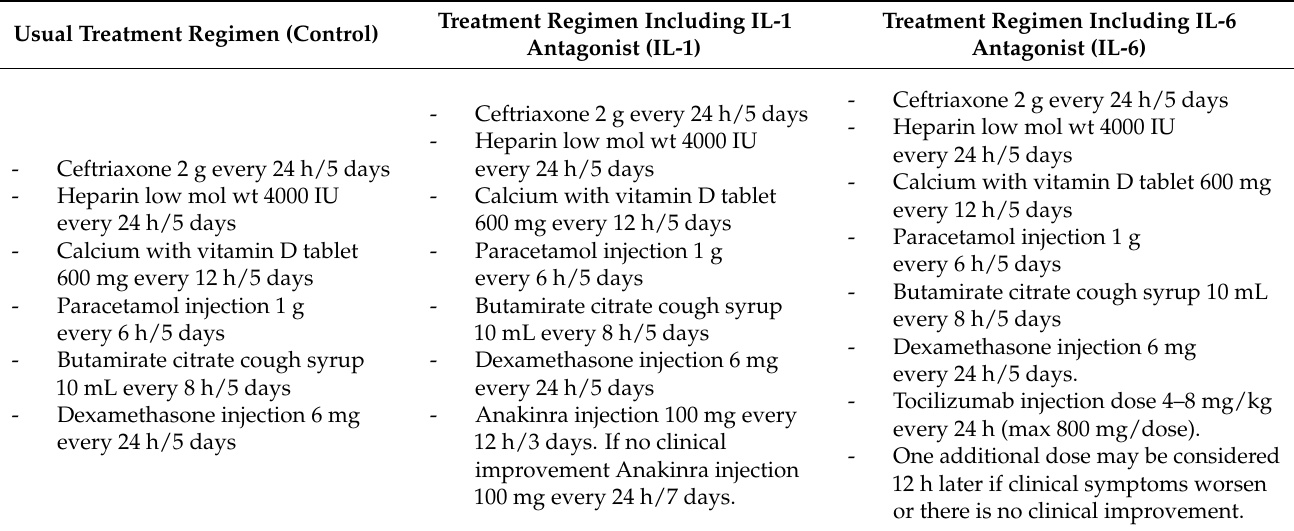
Table 1. Treatment